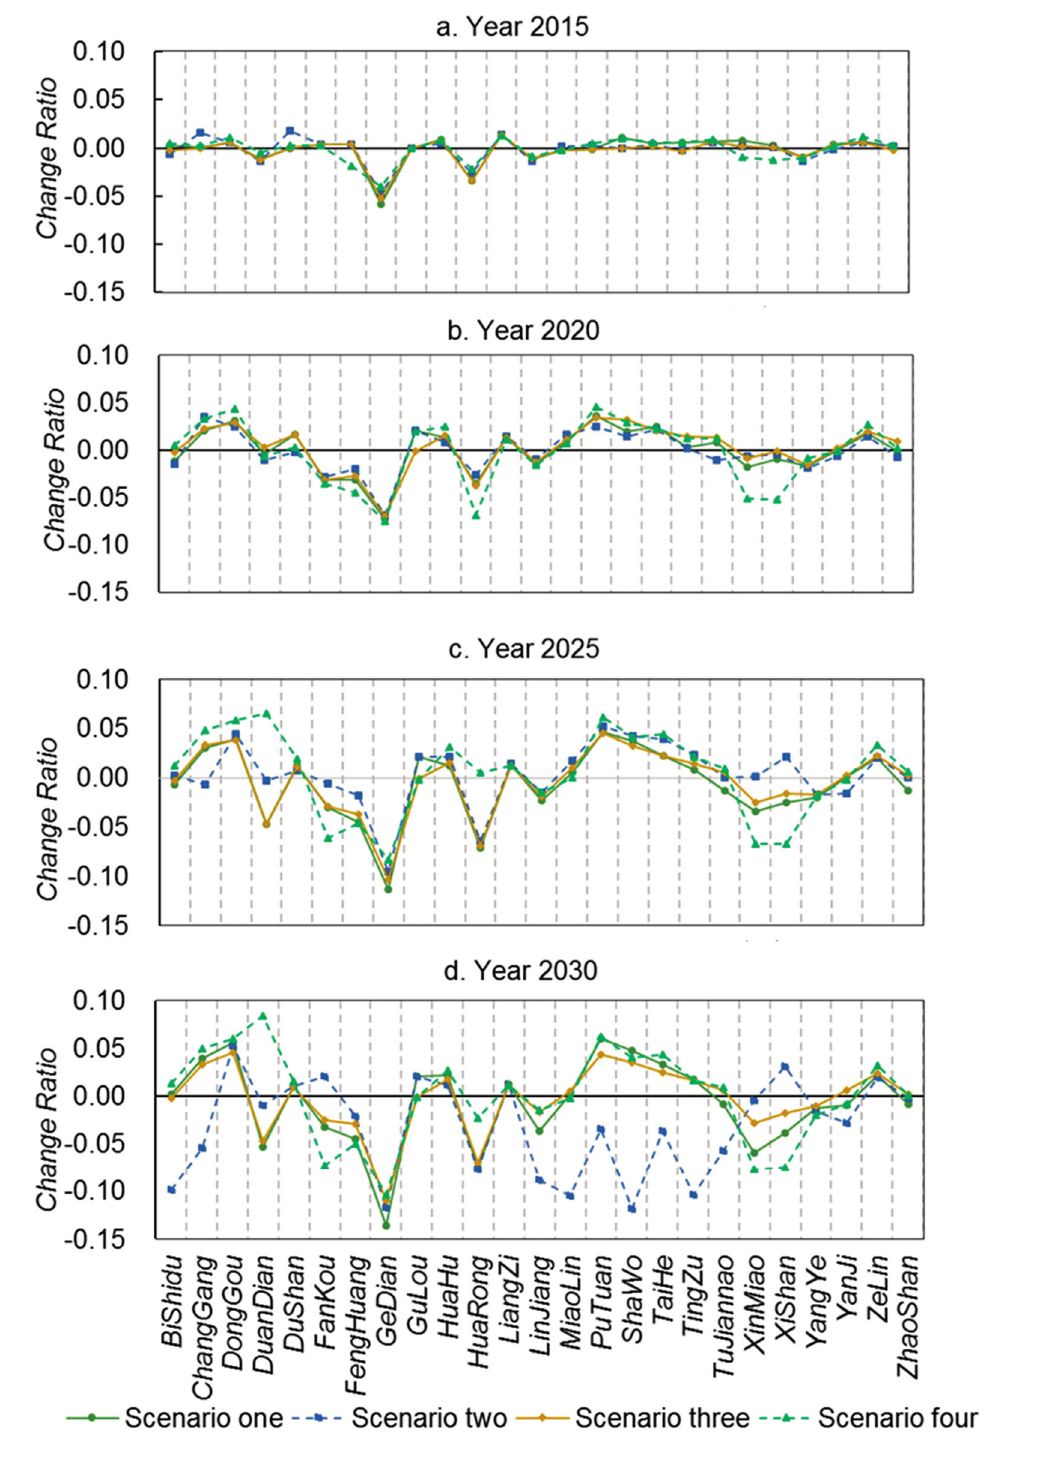
Figure 10. Temporal change of landscape ecological risks at the town level for different scenarios (with respect to